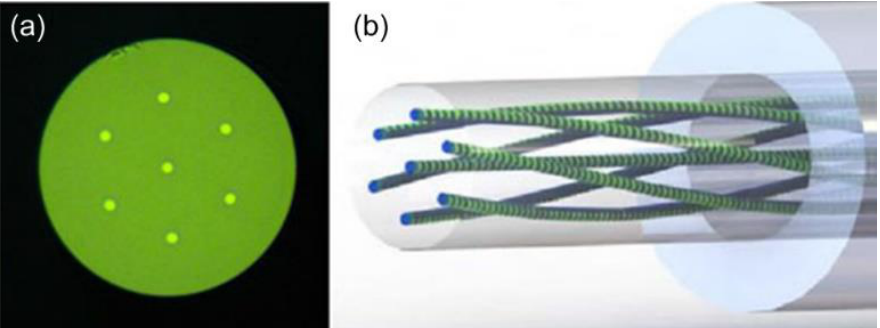
Figure 20. ( a ) End-view image of a seven-core fiber with coating removed; ( b ) twisted multicore fiber schematic showing UV transparent coating (right). Bare glass region (left) shown to highlight twisted multicore continuous gratings. Adapted with permission from Ref. [77] © 2017